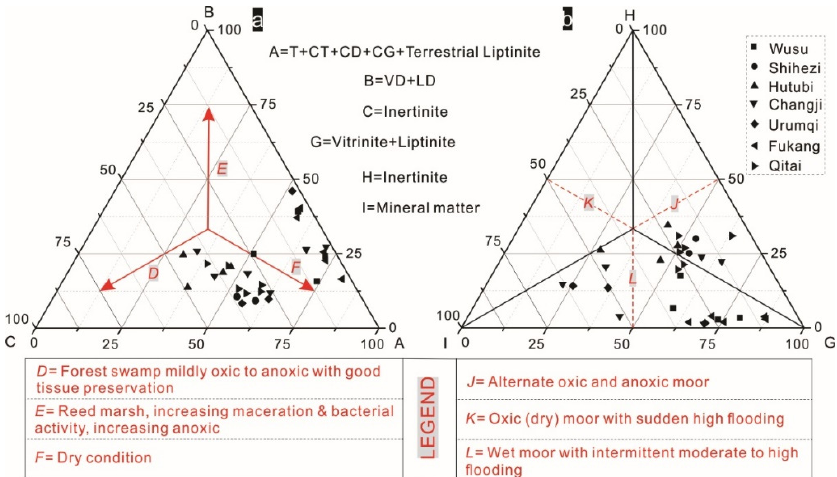
Figure 5. Triangular diagram illustrating peat-forming depositional environments of the southern Junggar Coalfield (base map modified from [19,49]). Based on maceral assemblages ( a ) the investigated samples basically derive from forest swamp with slightly oxic to anoxic conditions, with good tissue preservation. Based on coal mass compositions ( b ) the SJC samples were subjected to two moors. Two-thirds of the coals represented a wet moor with intermittent moderate to high flooding. One-third of the coals represent an oxic (dry) moor with sudden high